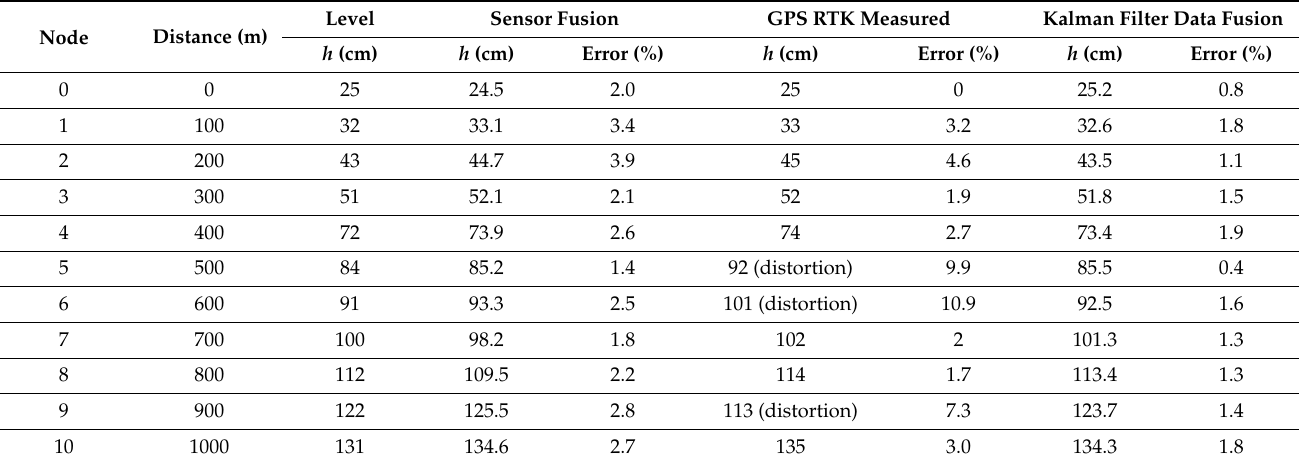
Table 3. Comparison of detection